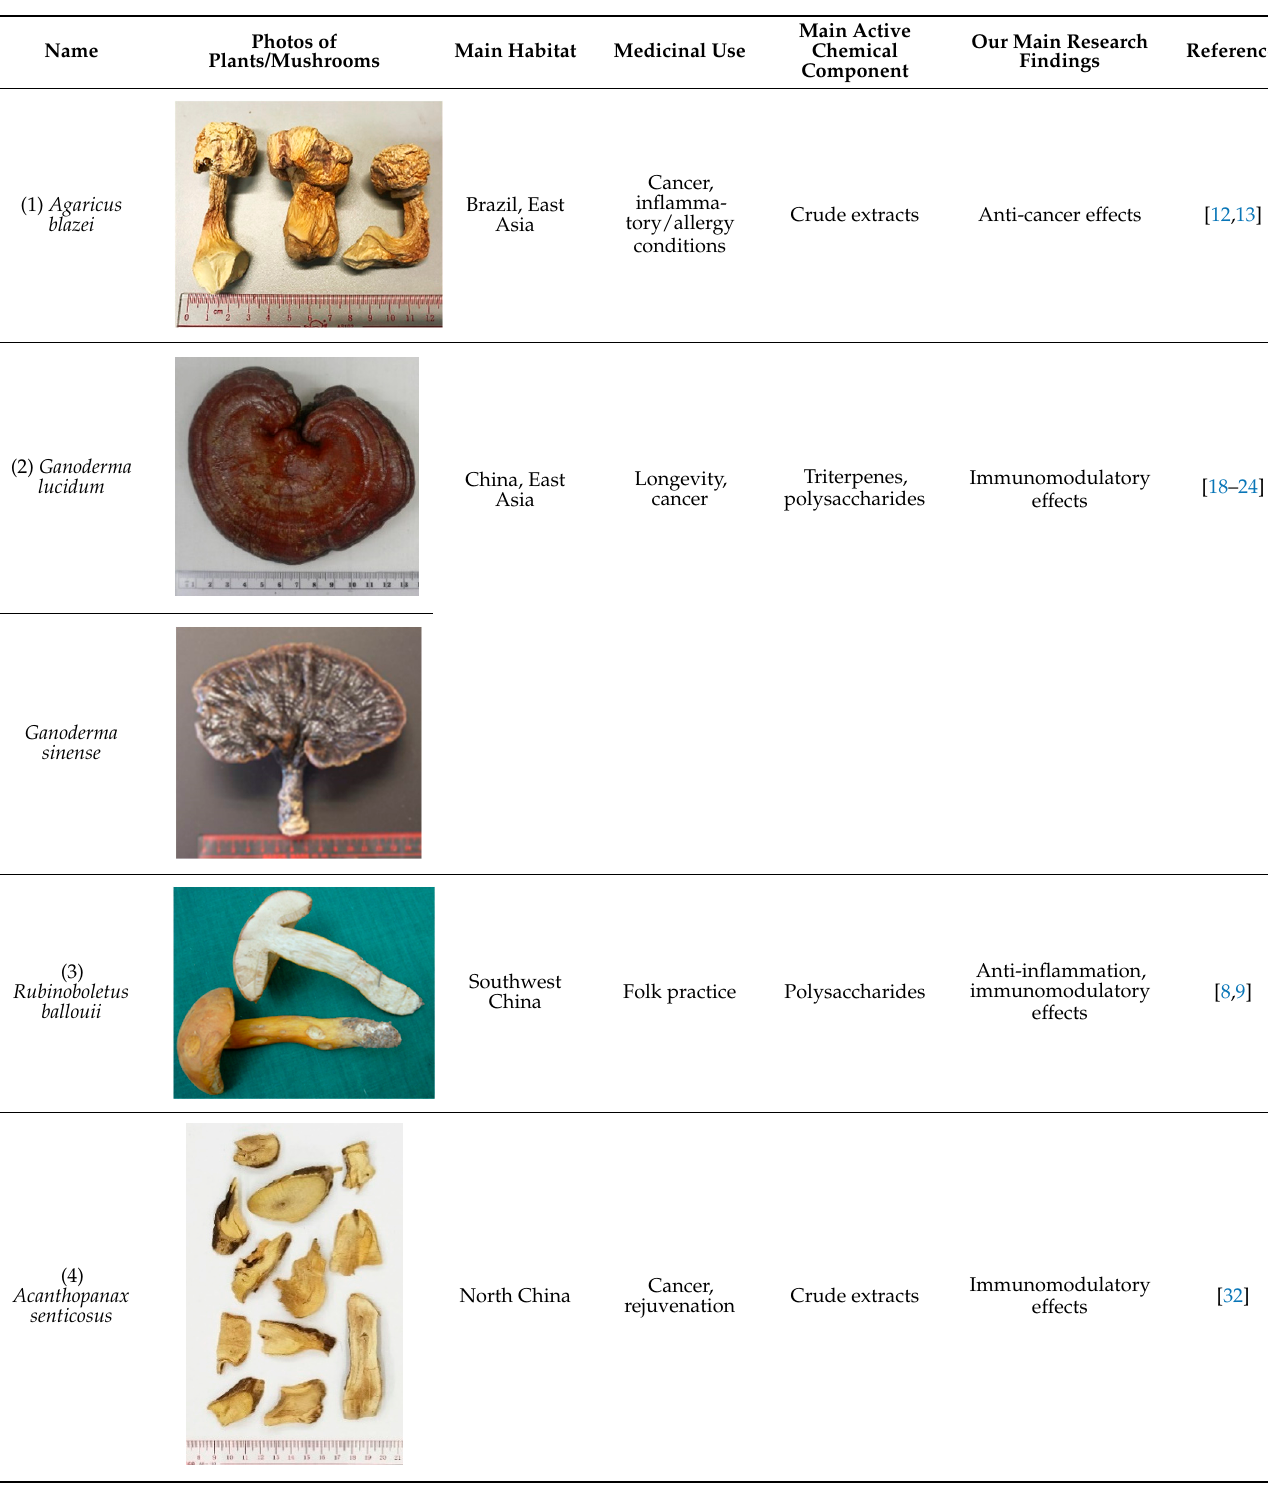
Table 1. Medicinal plants and mushrooms with anticancer and immunomodulatory effects described in the text. Name Photos of Plants/Mushrooms